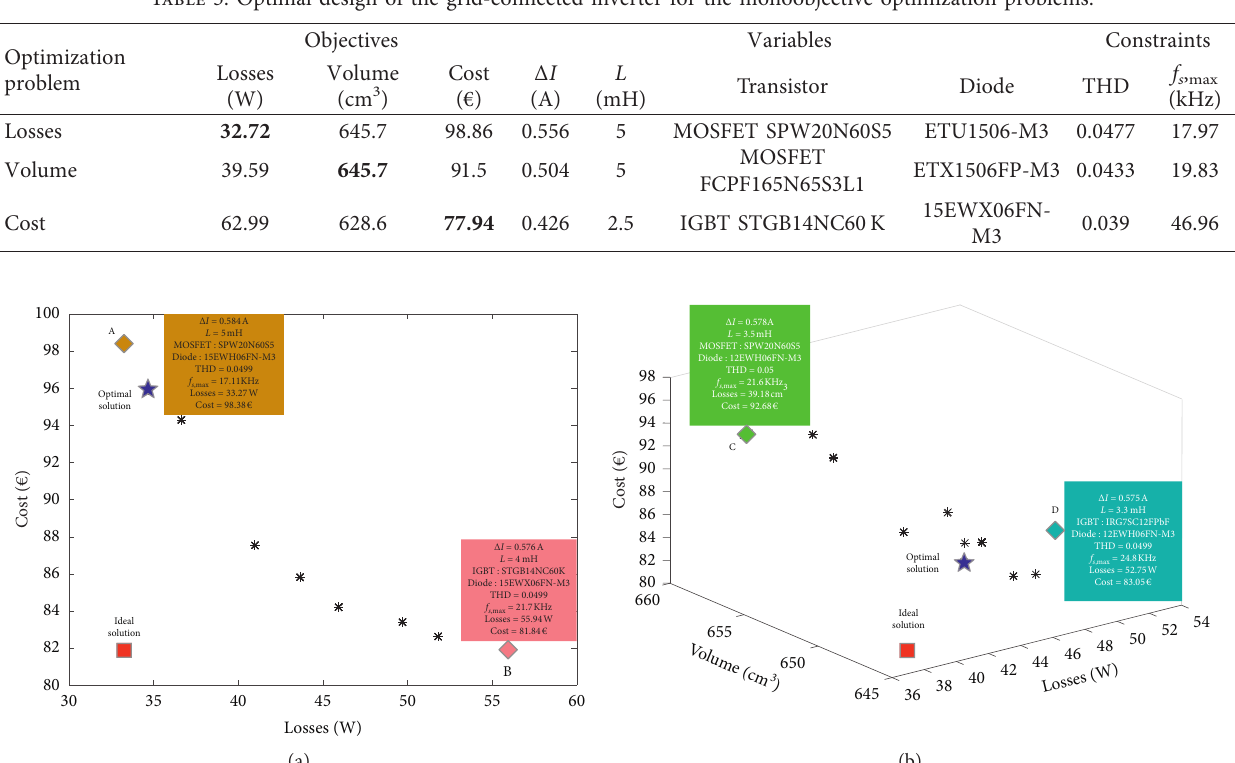
Table 5: Optimal design of the grid-connected inverter for the monoobjective optimization problems.